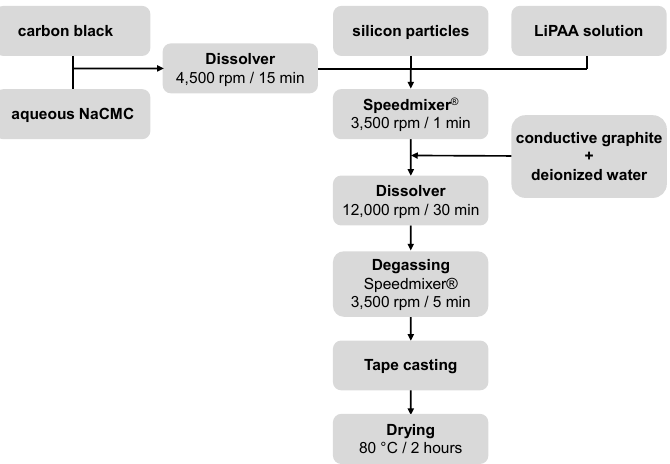
Figure 2. Process steps for preparation of the microsilicon-containing anodes.